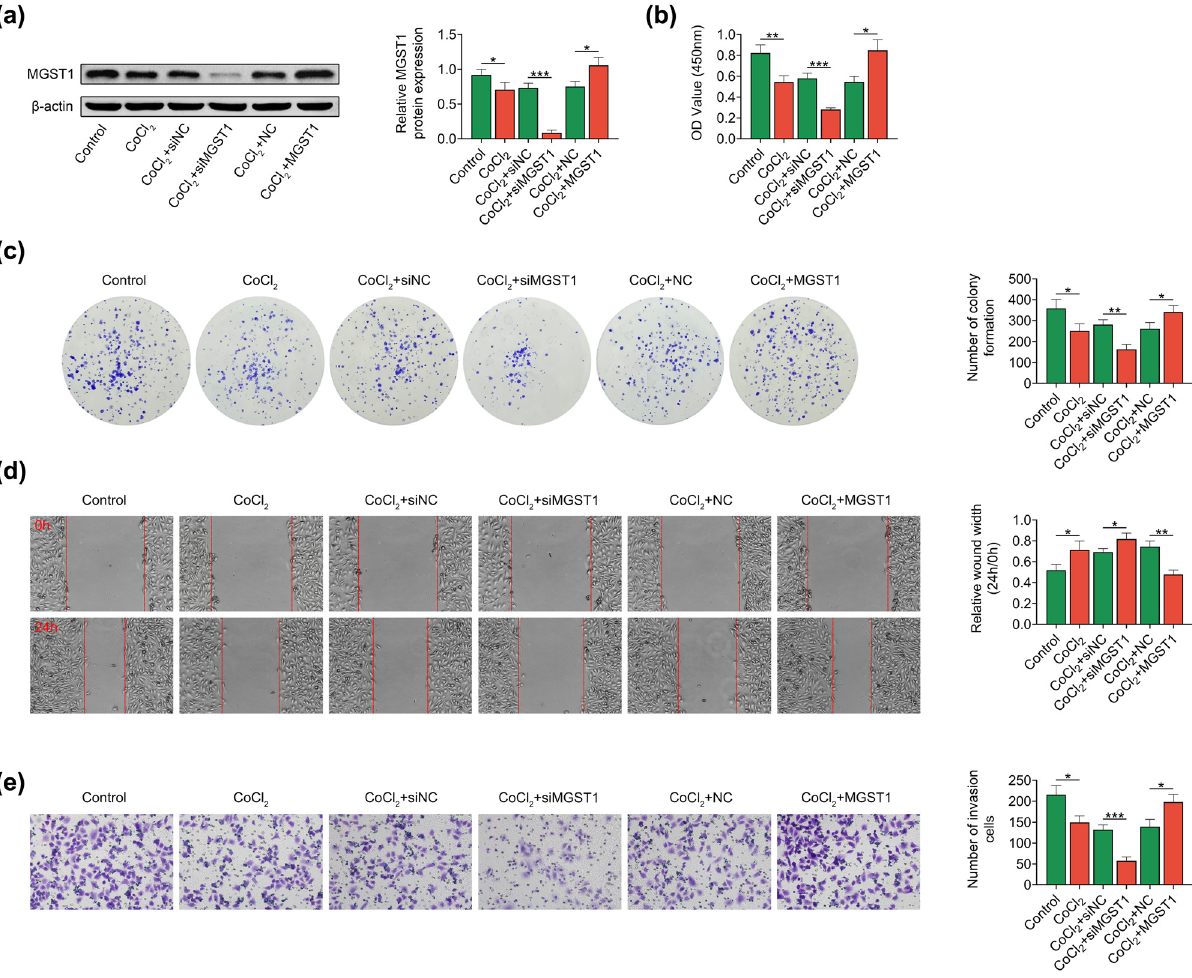
Figure 2: Overexpression of MGST1 increased the hypoxia - induced trophoblast cell proliferation, migration, and invasion. Groups were divided into the control, CoCl 2 , CoCl 2 + siNC, CoCl 2 + siMGST1, CoCl 2 + NC, and CoCl 2 + MGST1 group. ( a ) The protein level of MGST1